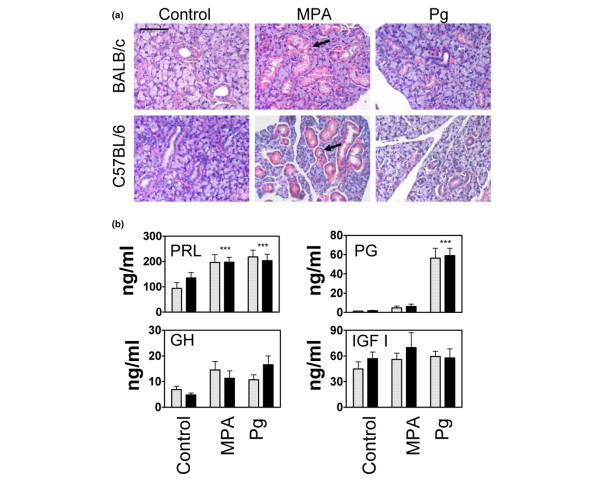
Effects of progestins in salivary gland morphology and in serum pituitary hormone levels. (a) Salivary glands from control, MPA, or Pg-treated BALB/c or C57BL/6 mice. Pellets were implanted subcutaneously and the animals killed after 2 months. MPA increased the development of convoluted granular ducts (arrow). No differences were observed between both strains of mice (400×, bar: 120 μm). (b) Serum PRL, Pg, GH, and IGF-I levels measured by radioimmunoassay in control BALB/c or C57BL/6 female mice and after 24 hours of MPA or Pg treatment. No differences were detected in C57BL/6 mice as compared with BALB/c mice. Furthermore, Pg and MPA treatment induced an increase in PRL levels in both strains (P < 0.001, two-way ANOVA). The increase in Pg levels after progesterone administration was also similar in both strains (P < 0.001, two-way ANOVA). Gray bars: BALB/c; black bars: C57BL/6. ANOVA, analysis of variance; GH, growth hormone; IGF, insulin-like growth factor; MPA, medroxyprogesterone acetate; Pg, progesterone; PR, progesterone receptor; PRL, prolactin.